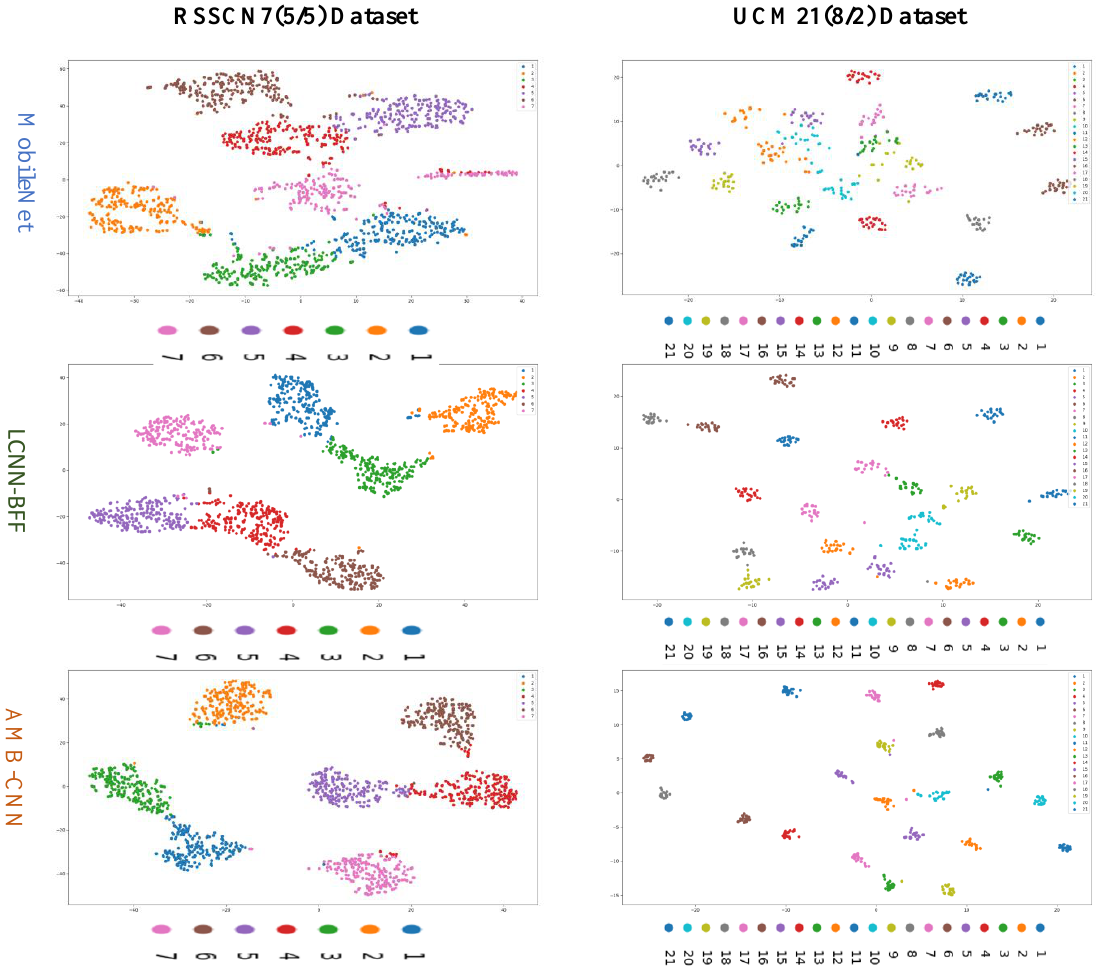
Figure 18. T-distributed stochastic neighbor embedding (T-SNE) visualization analysis of the three methods.